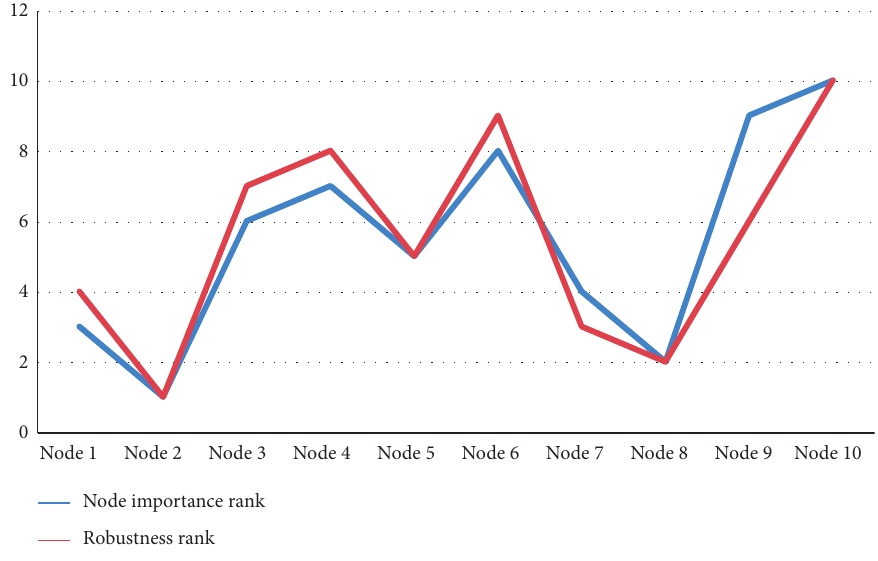
Figure 2: Comparison of node importance ranking and robust